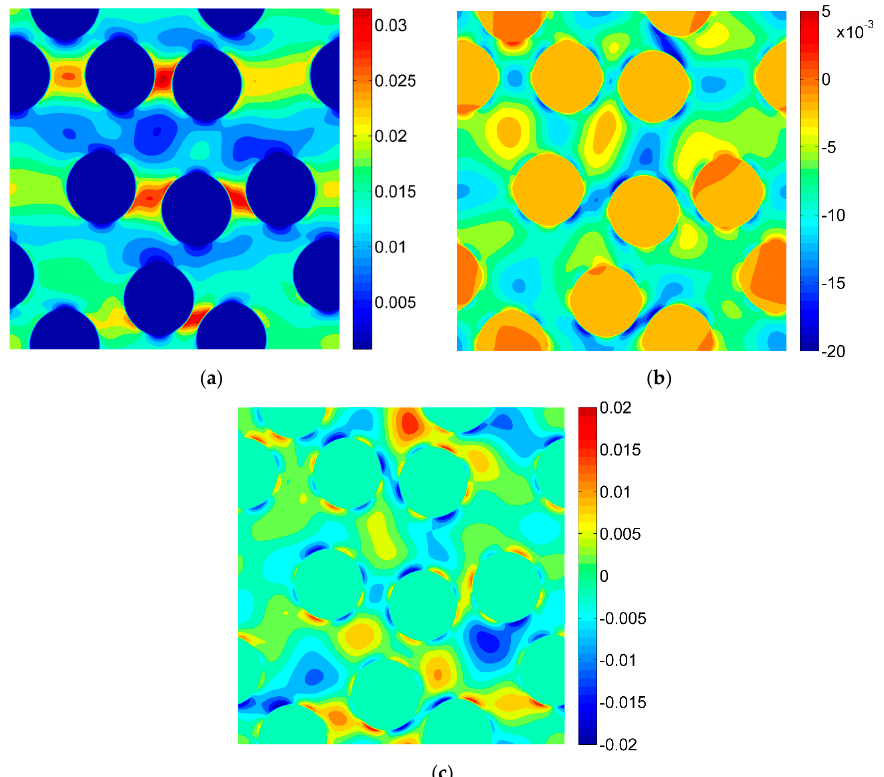
Figure 7. Strain fields obtained by using the finite element method (FEM) for Material 1 ( a ) ε 11 ; ( b ) ε 22 ; ( c ) ε 12.